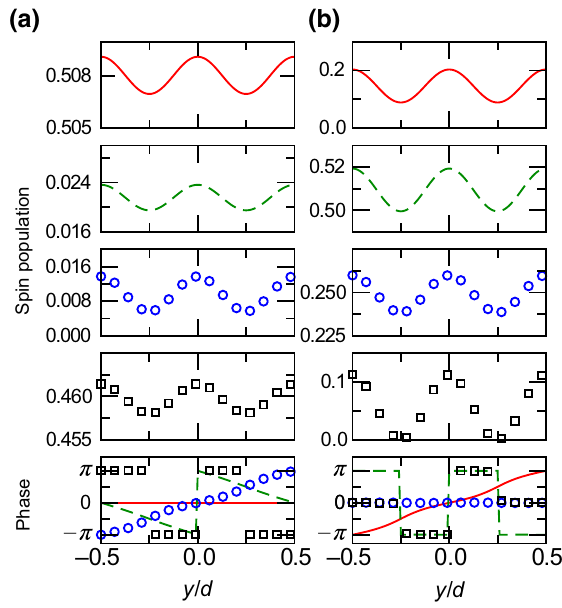
FIG. 5. Spin population and phase versus y for case 1 (see the text). Calculations are performed for a BEC at q y = 0 in the (a) ground band and (b) first excited band. The red line, green dashed line, blue circles, and black squares correspond to the spin states | 1 (cid:2) , | 2 (cid:2) , | 3 (cid:2) , and | 4 (cid:2) , respectively. The plotted popula- tion of the spin component i , ρ i , is normalized by the condition (cid:11)